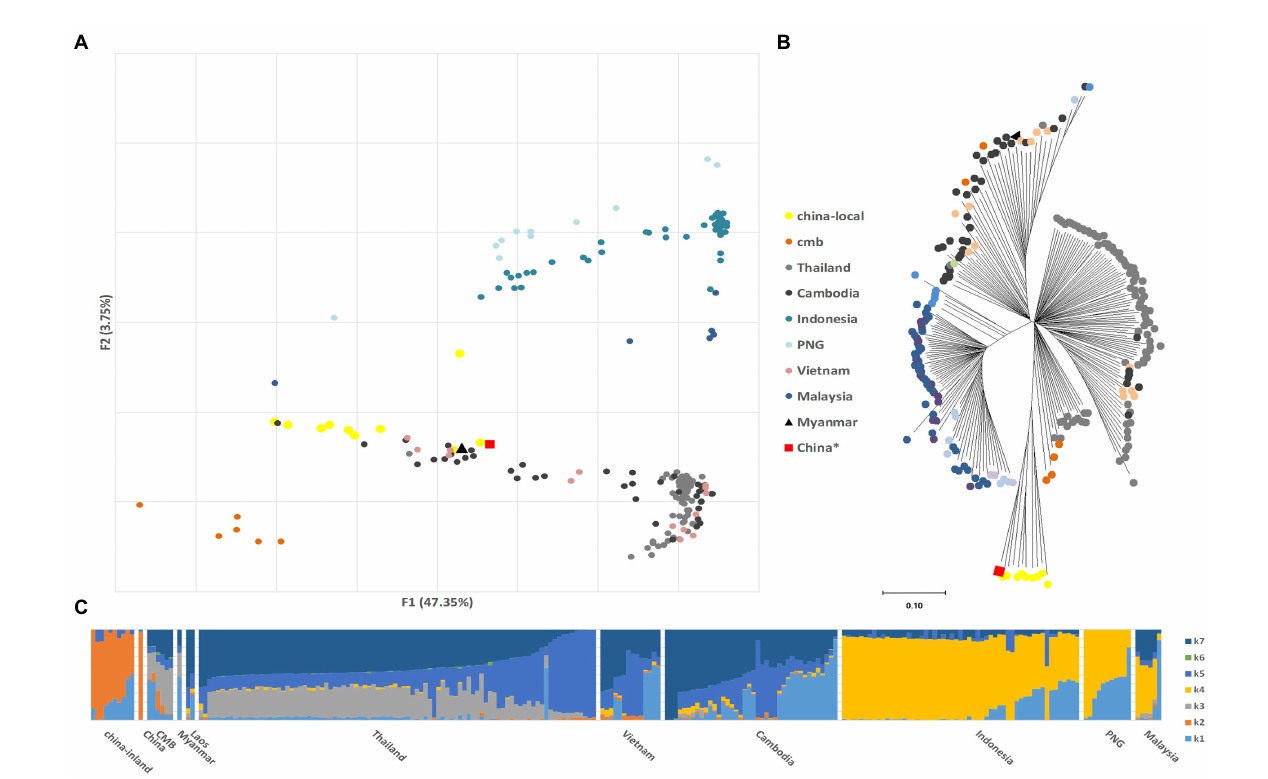
FIGURE 1 Parasite population structure in China inland samples relative to the reference (Cambodia, China*, India, Indonesia, Laos, Malaysia, Myanmar, Thailand, Vietnam, and Papua New Guinea). The China* samples (SAMEA2358527) are also downloaded from the study of Pearson et al. (2016), which was collected from the Yunnan border area, China in 2011, and published on ENA in 2014. (A) Principal component analysis (PCA) plots illustrating the genetic differentiation between populations; (B) Neighbor-joining tree illustrating the relatedness between the inland Plasmodium vivax isolates relative to the reference with 1,000 bootstraps. (C) ADMIXTURE bar plot illustrates the population structure within and among populations at an optimized cluster value of K =